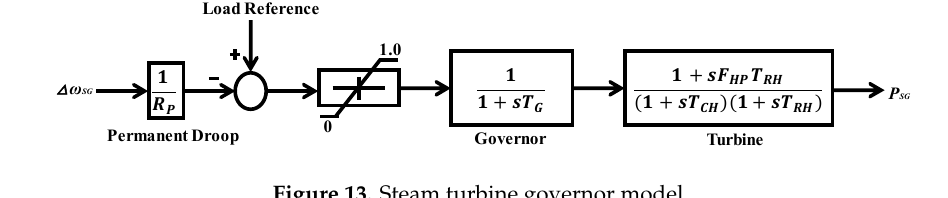
Figure 12. IEEE type AC4A excitation system model.